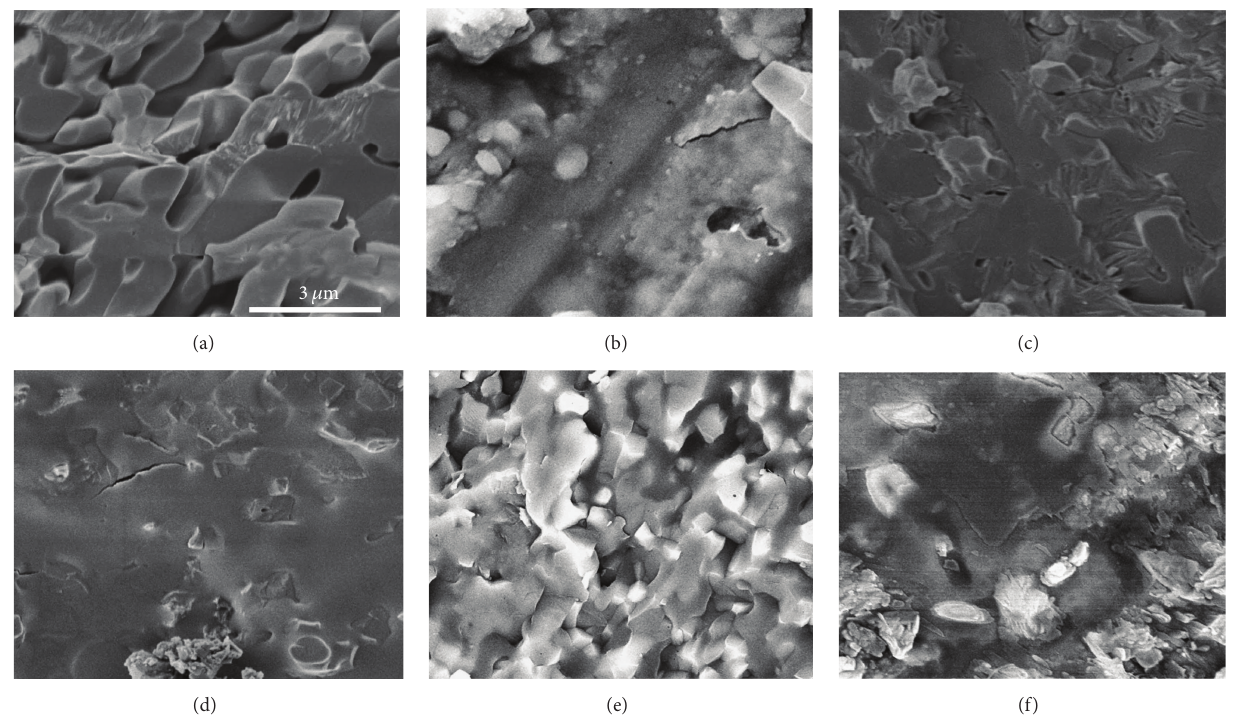
Figure 1: Cross-sectional scanning electron microscopy images of (a) HAp, (b) PGA/HAp, (c) PLGA20/HAp, (d) PLGA50/HAp, (e) PLGA80/Hap, and (f) PLLA/HAp composites polymerized at 100 ∘ C for 9 days (originally adapted from